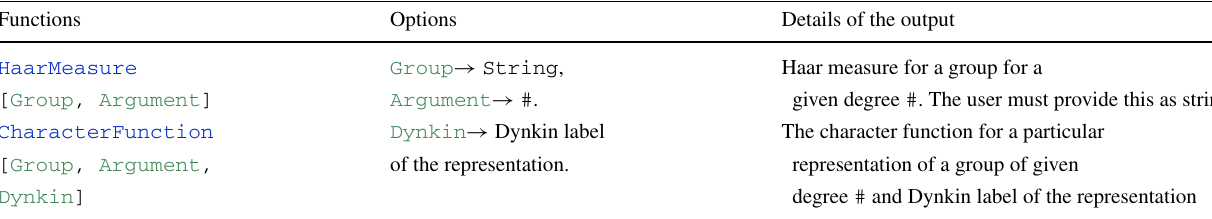
Table 16 Output functions of CHaar and their working